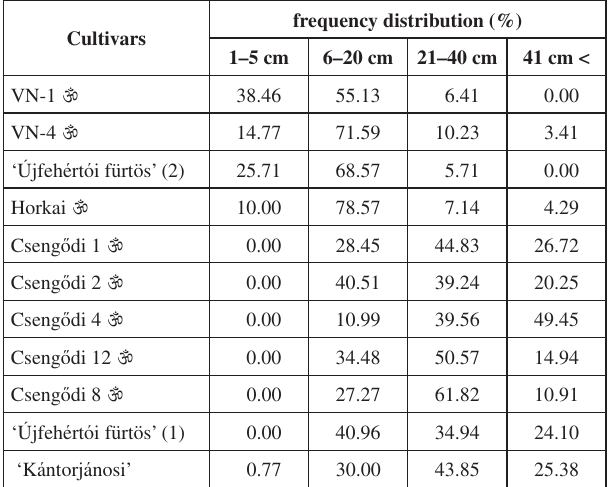
Table 3: Frequency distribution of shoots of cultivars in different size